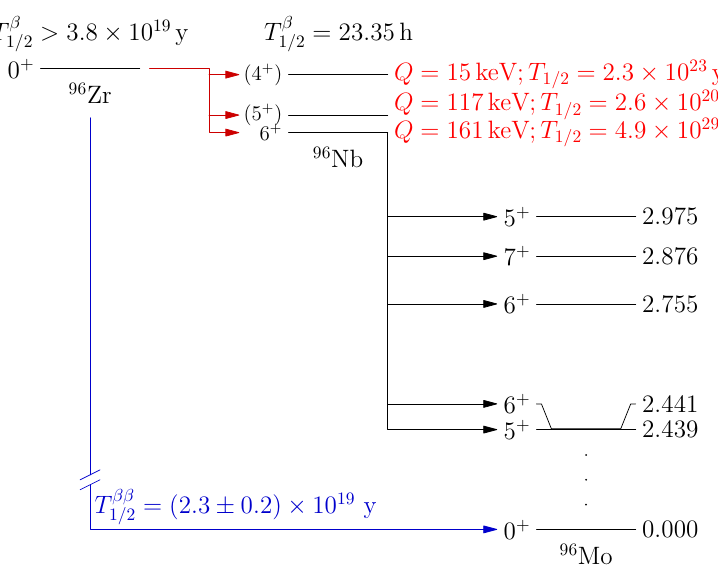
Figure 5. Ultra-slow beta-decay transitions from the ground state of 96 Zr to the three lowest states in 96 Nb, and the subsequent beta decay to states in 96 Mo. The experimental Q values and computed half-lives are given to the right of the energy levels and the experimental lower limit of the total β − decay half-life is given in the up left corner of the figure. Shown is also the experimental half-life of the direct double-beta-decay transition to the ground state of 96 Mo. The numbers to the right of the 96 Mo energy levels are excitation energies in